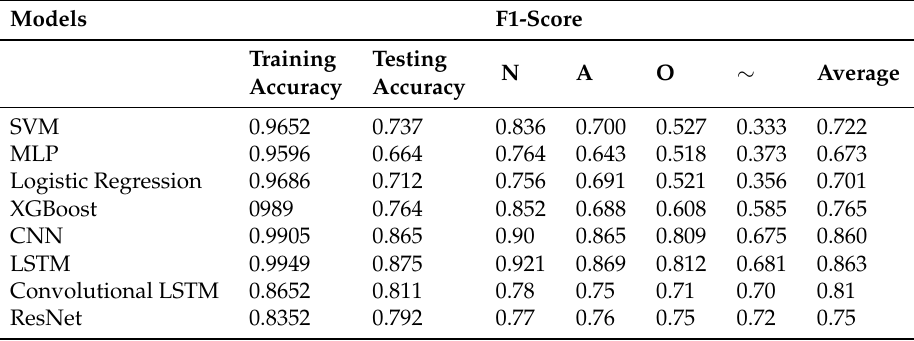
Table 3. Summary of machine learning (ML) and deep learning (DL) classifiers—PhysioNet.